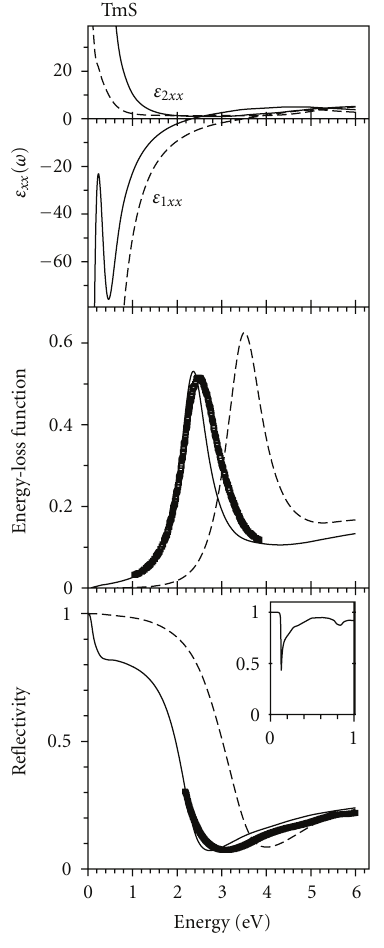
Figure 64: Calculated real and imaginary parts of the diagonal dielectric function, ε 1 xx , ε 2 xx , energy-loss function, and the optical reflectivity R of TmS [384] treating 4 f states in core (dashed line) and by the LSDA+ U approximation (solid line) compared with experimental data (solid circles) [389].